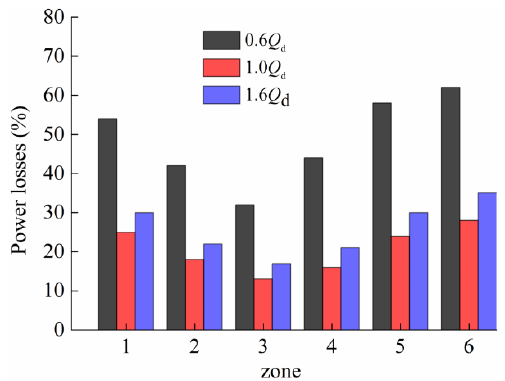
Figure 17. Hydraulic losses of different zones.